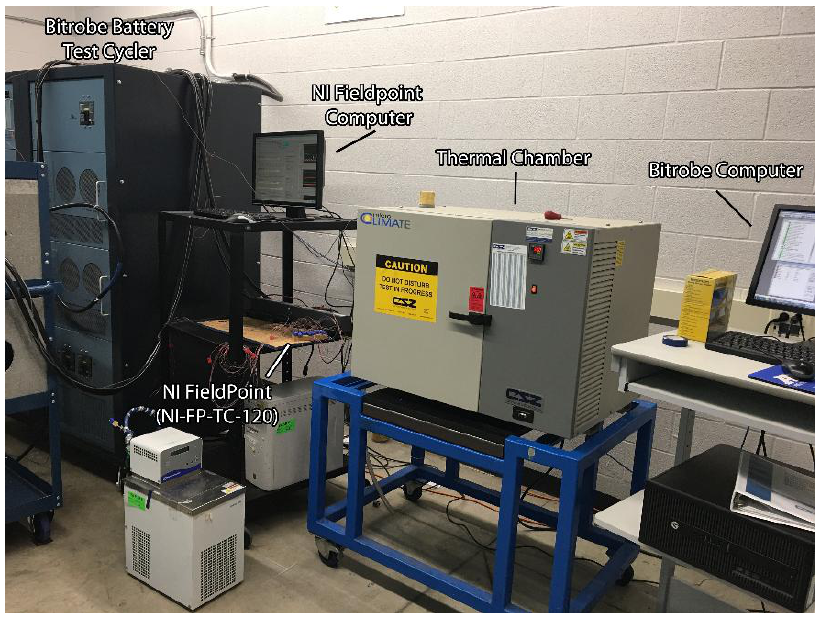
Figure 1. Experimental set-up for model development and voltage validation.